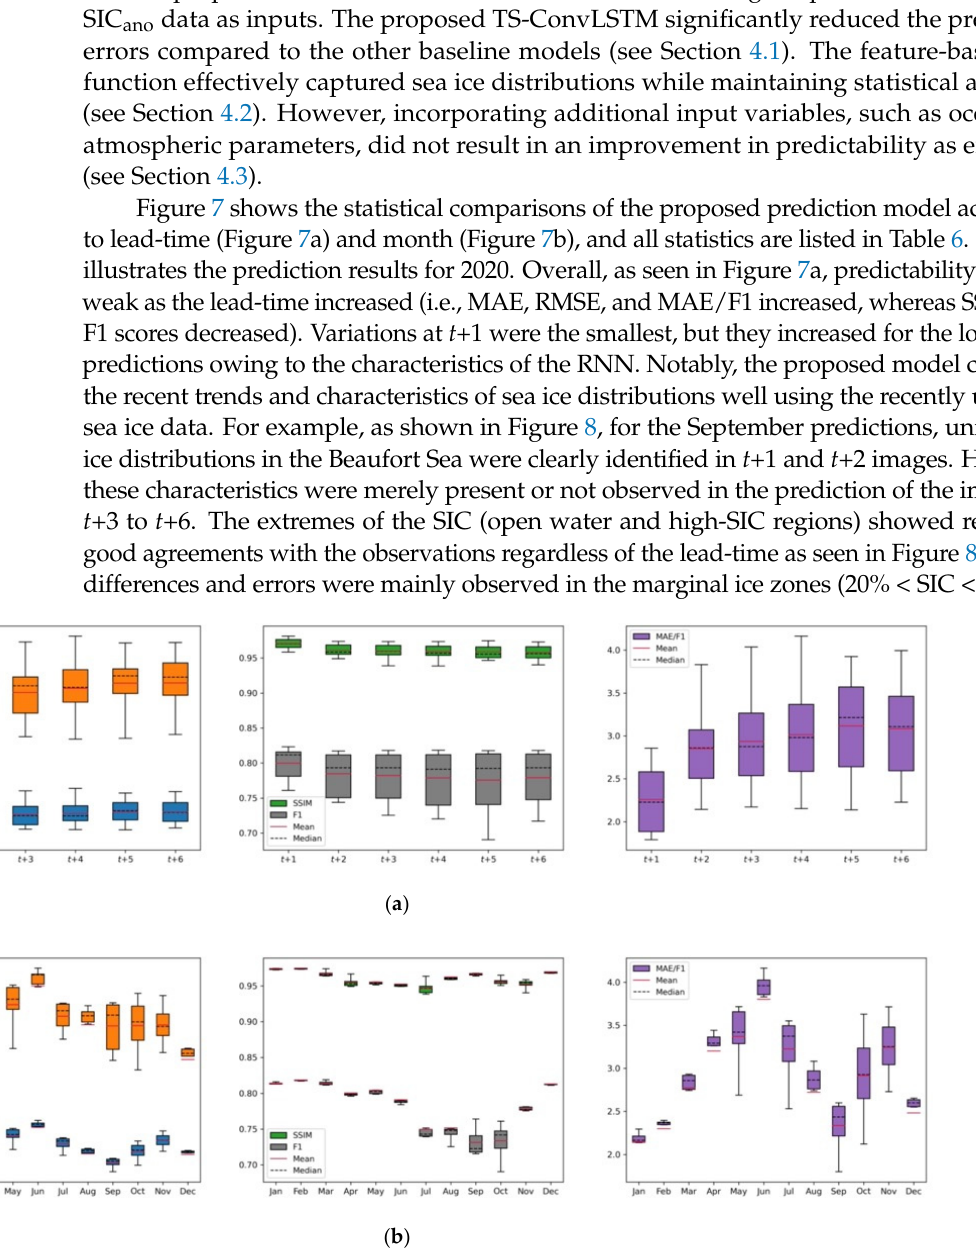
Figure 7. Box plots for statistical comparisons of the proposed approaches for the unseen test data according to ( a ) lead-time and ( b ) month. Table 6. Statistics of prediction errors according to lead-time and month.